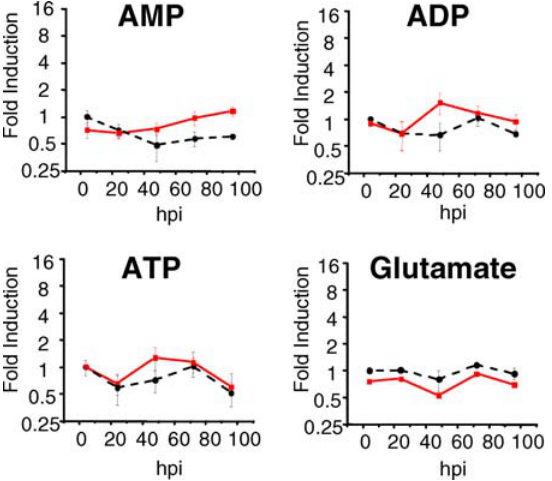
Figure 5. Homeostasis of Purine Nucleotides and Amino Acids during HCMV Infection Metabolite data from mock-infected (dotted line) or virally infected (red line) fibroblasts are plotted as described in the Figure 1